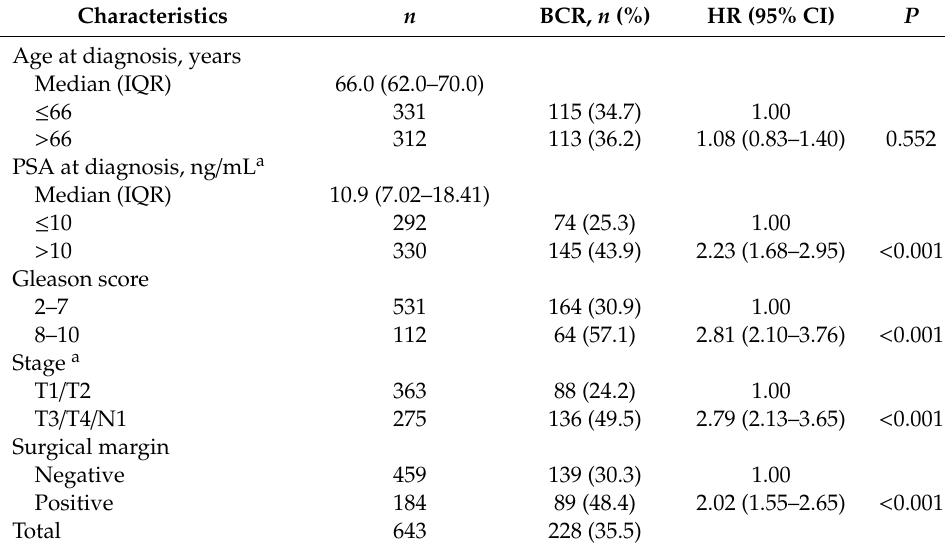
Table 1. Clinicopathologic characteristics of the study population.